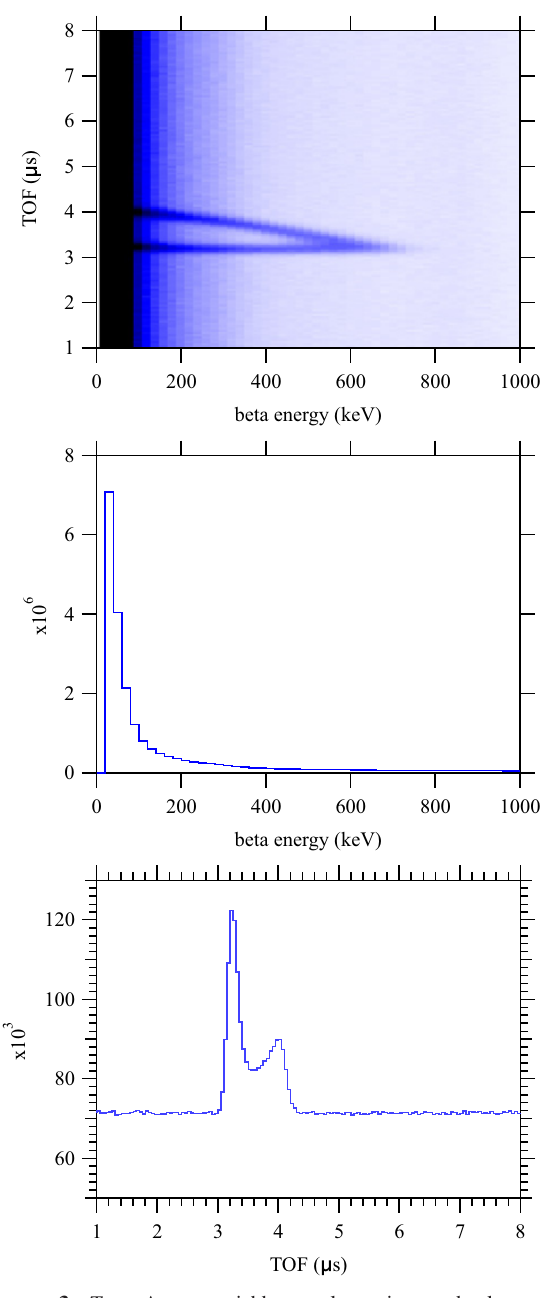
Figure 3. Top: A raw wishbone plot prior to background subtraction. Middle: The raw wishbone summed over time of flight, showing total counts vs. beta energy. Bottom: The raw wishbone summed over beta energy, showing total counts vs. time of